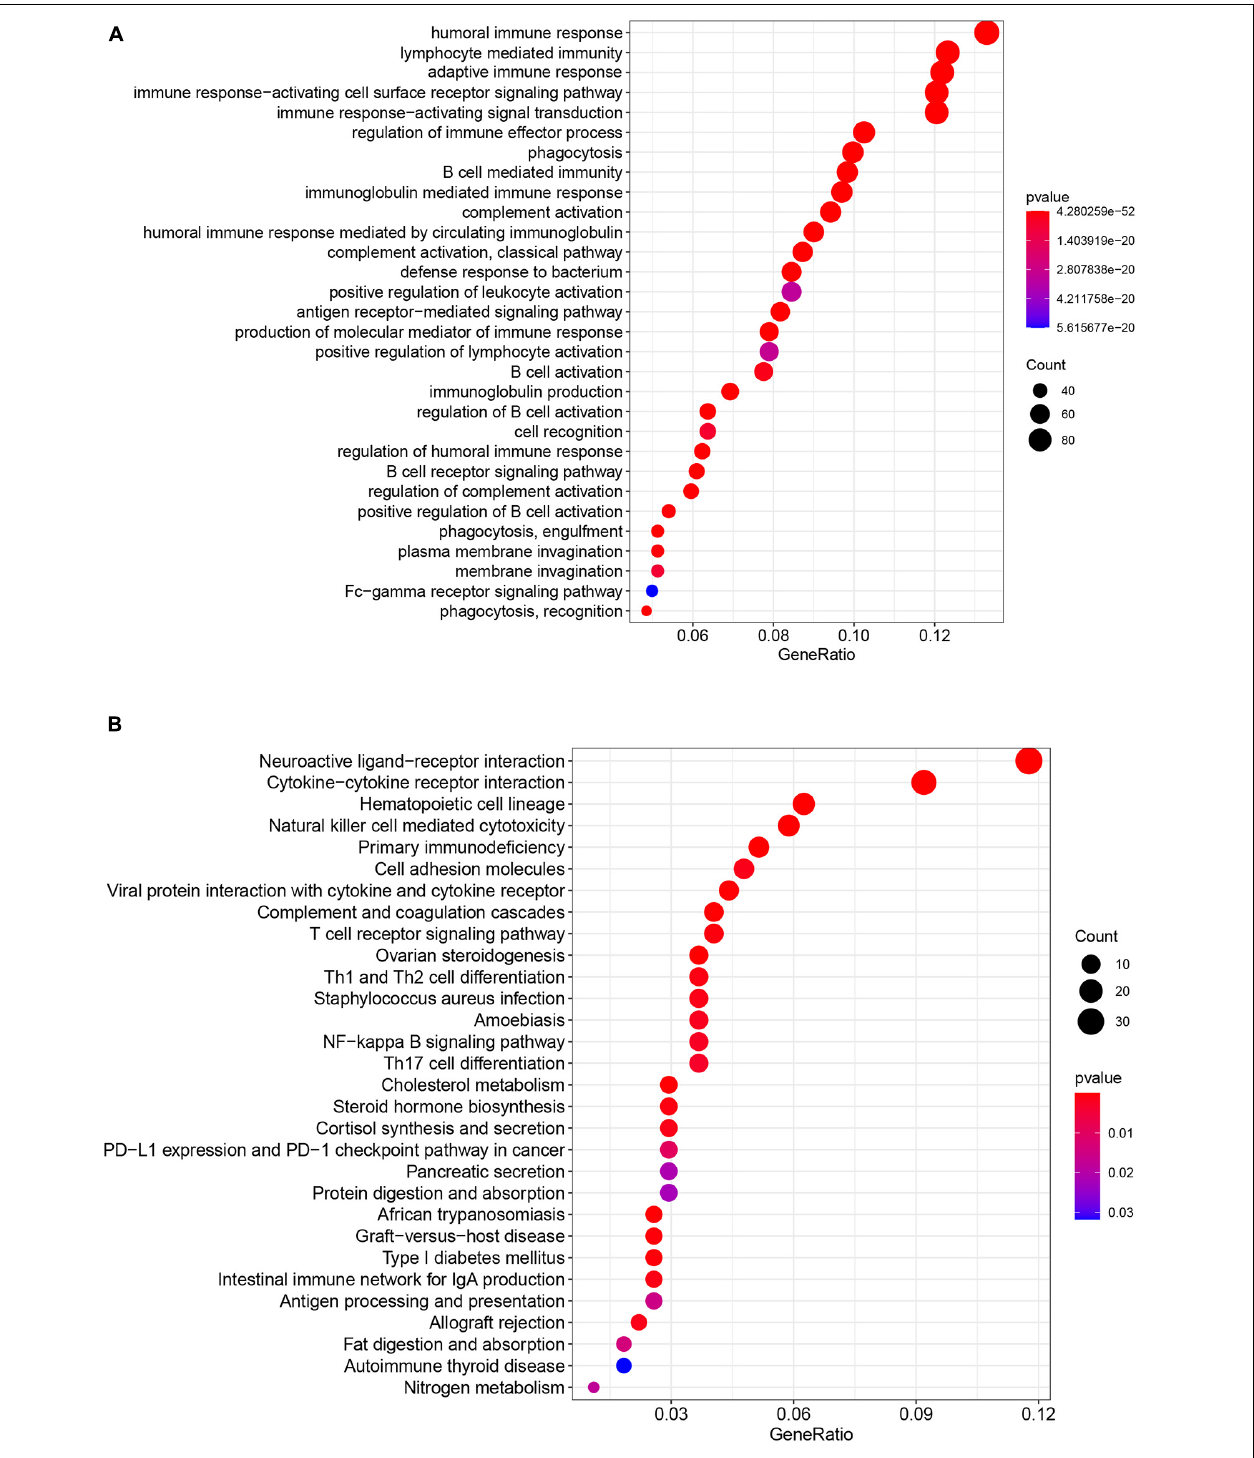
FIGURE 7 | Results of GO enrichment analysis and KEGG pathway analyses. (A) GO enrichment analysis suggests that the differentially expressed genes between the low-risk and high-risk groups are mainly enriched in immune-associated biological processes. (B) KEGG pathway analysis suggests that the differentially expressed genes between the low-risk and high-risk groups were mainly enriched in immune-associated pathways.